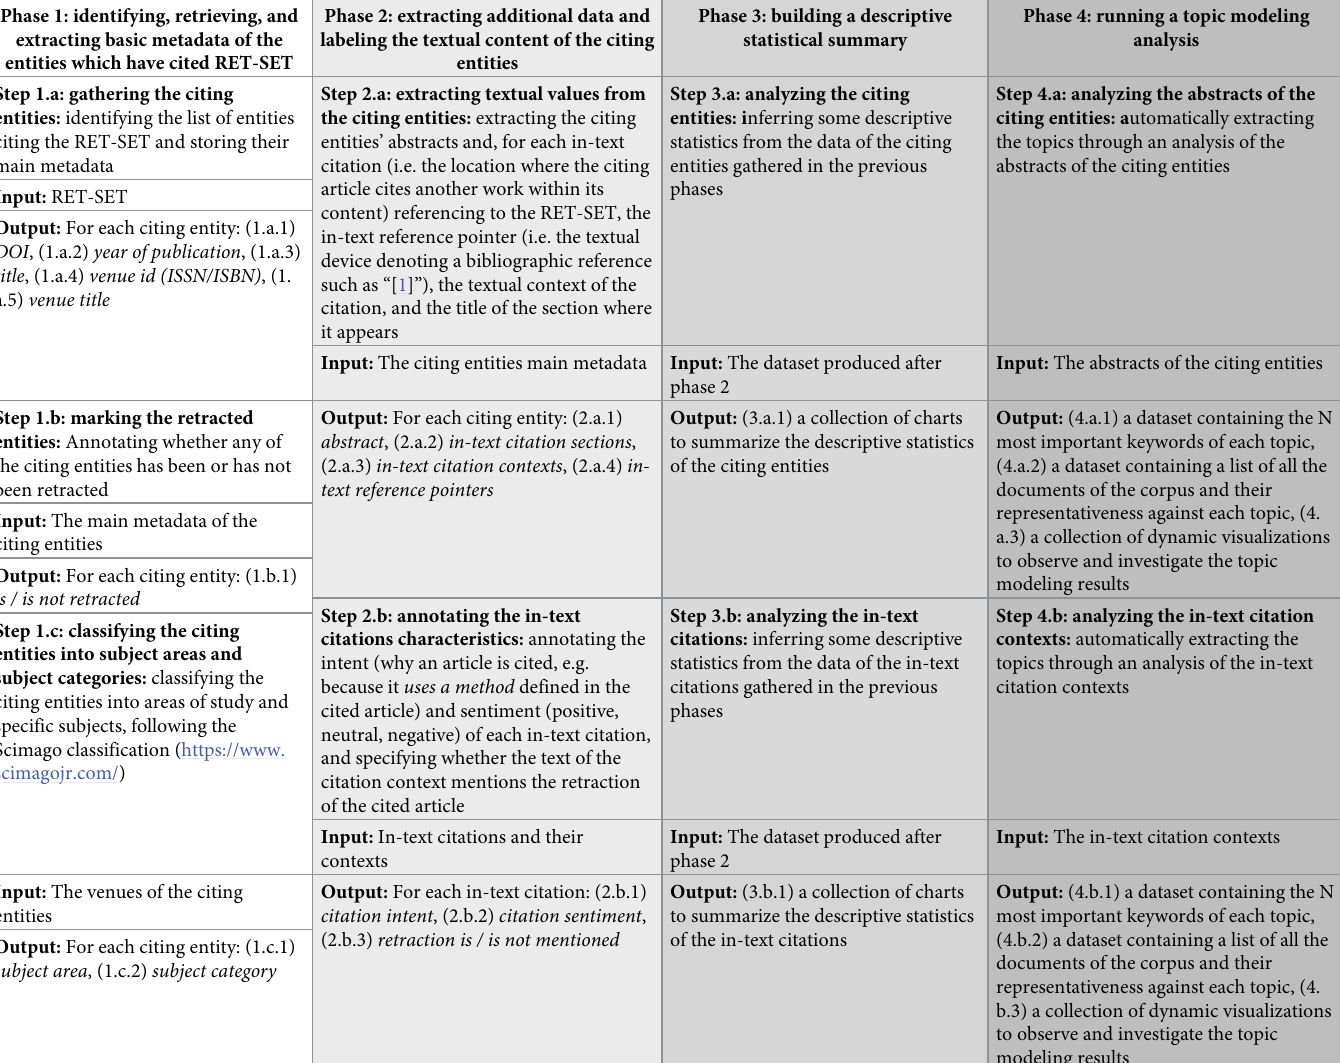
Table 1. An overview of the phases of the methodology described in this article. Phase 1: identifying, retrieving, and extracting basic metadata of the entities which have cited